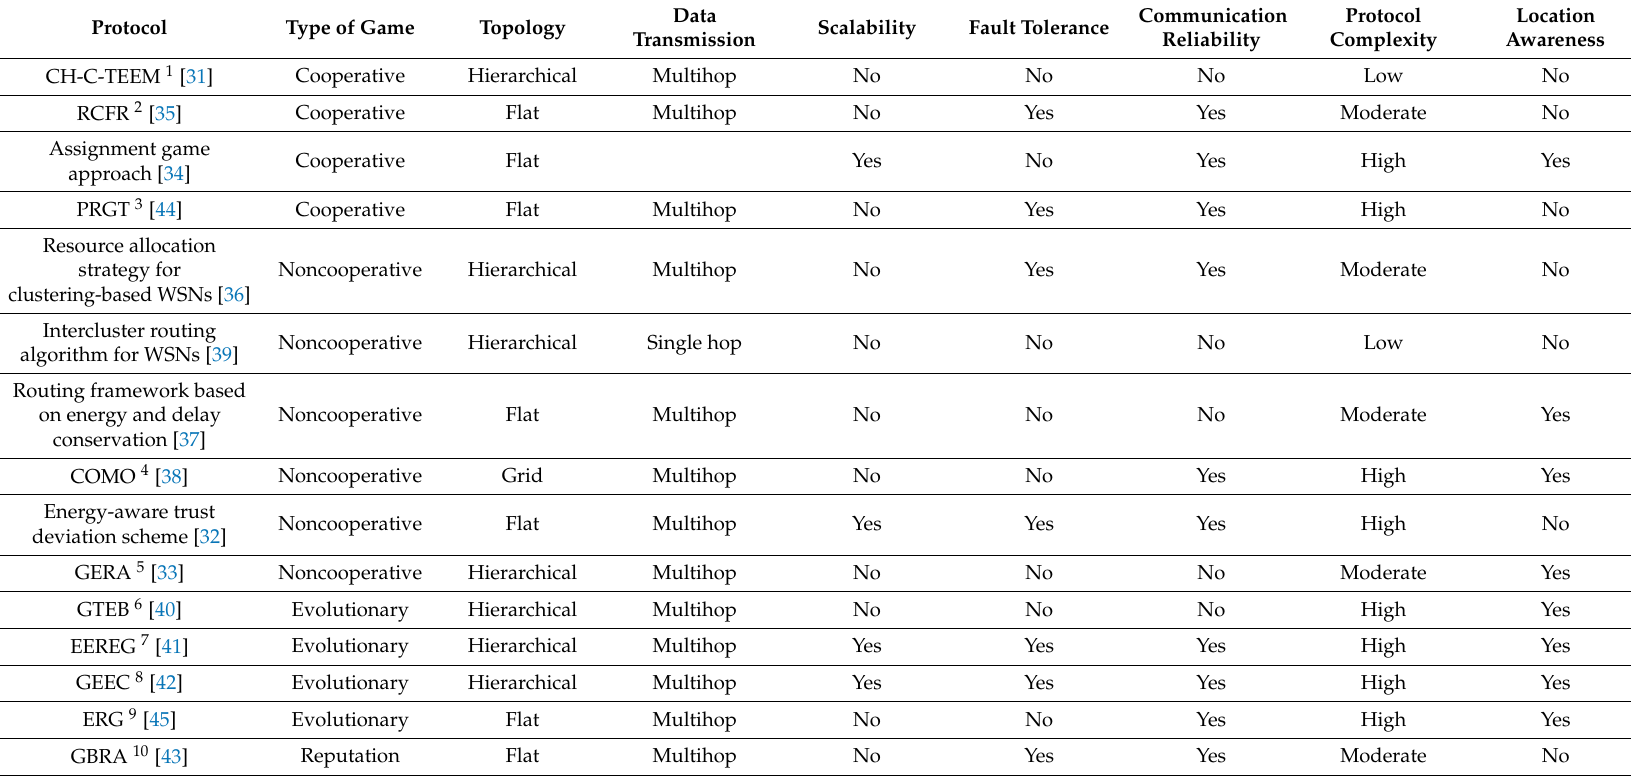
Table 10. Comparison of routing protocols with regard to network